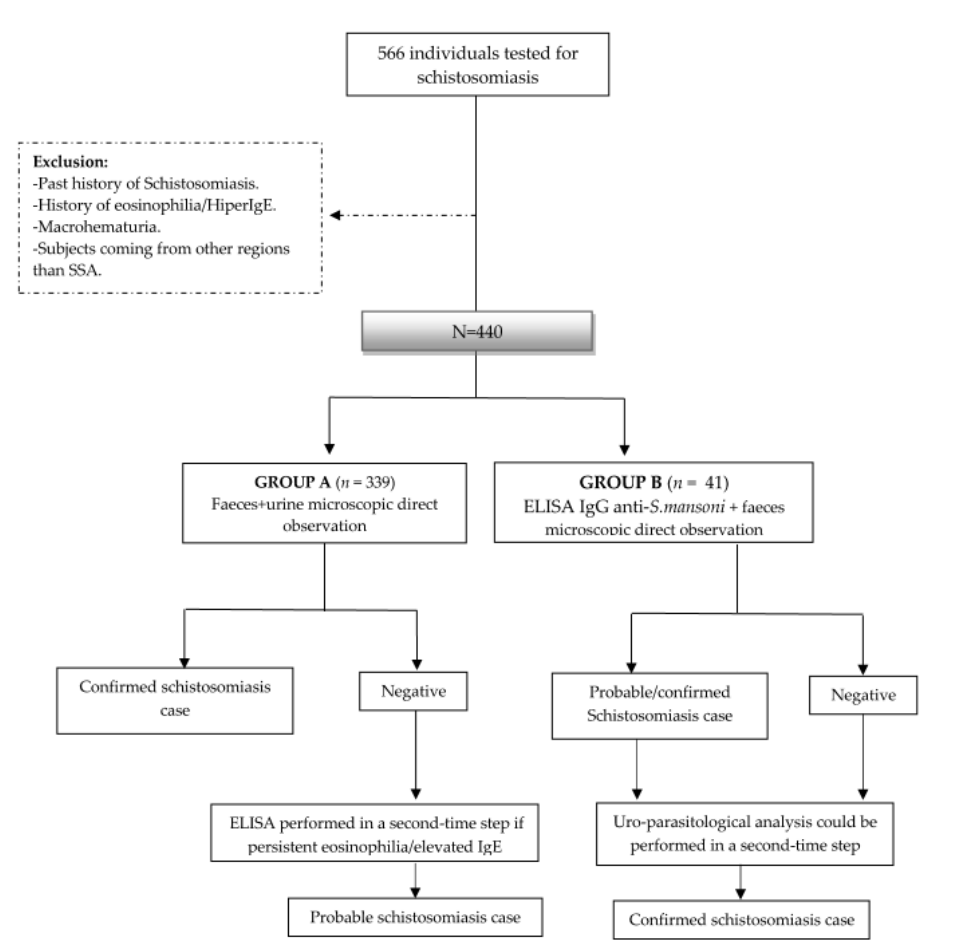
Figure 1. Study design and flowchart. ELISA enzyme-linked immunosorbent assay; IgE immunoglob- ulin E; IgG immunoglobulin G; S. mansoni Schistosoma mansoni; SSA Sub-Saharan Africa.